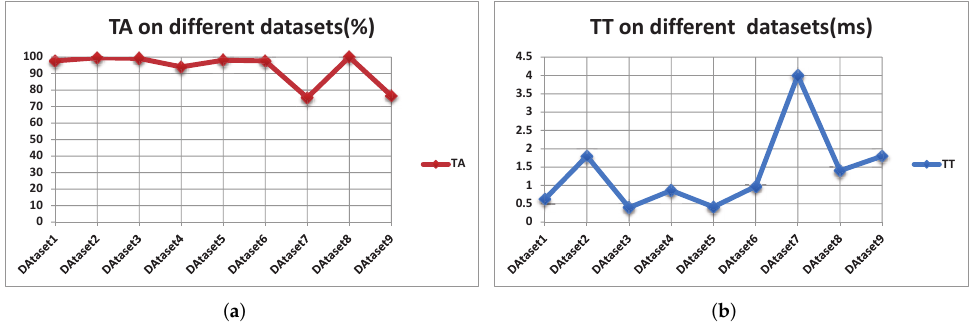
Figure 6. ( a ) Testing accuracies on different datasets with the proposed features and ( b ) training times on different datasets with the proposed